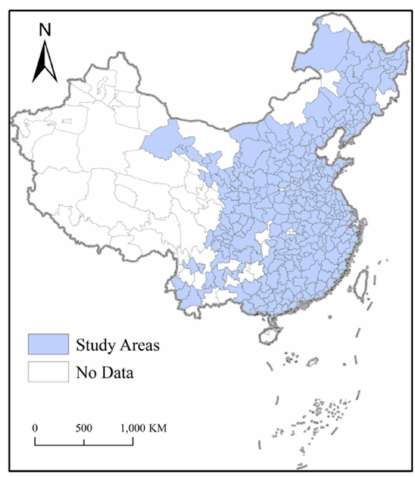
Figure 1. Location of study